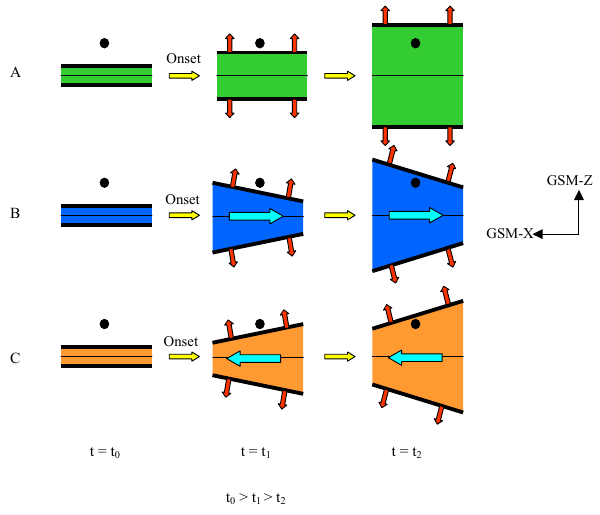
Fig. 20. The normal vectors (red) of the lobe – plasma sheet bound- ary as the plasma sheet expands: ( A ) uniformly down the X axis; ( B ) tailwards from near the Earth; ( C ) and, earthwards from tail- ward of the spacecraft. For each case, the plasma sheet prior to on- set and its subsequent expansion is shown. Any propagation direc- tion of the expansion is also shown (cyan). The spacecraft quartet is shown as a black